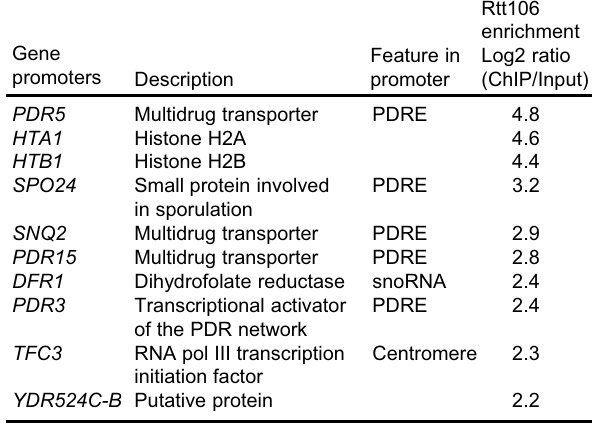
Fig. 1 Rtt106 binds promoters containing PDRE features. a Association of Rtt106 with the promoter of the histone gene pair HTA1-HTB1 , validating ChIP-seq analysis of Rtt106-6HA performed in this study. RTT106-6HA cells in log phase were collected for ChIP-seq analysis. Input, sequence reads of the sonicated genomic DNA before ChIP. Rtt106 ChIP, sequence reads of ChIPed DNA with Rtt106-6HA. b ChIP-seq analysis of Rtt106 showing association of Rtt106 with the promoter of the PDR5 gene. Positions of PDRE indicated by magenta lines. PDRE PDR responsive element. c The top 10 peaks of Rtt106 binding at promoter regions. Enrichment of Rtt106 at promoters was calculated as ChIP sequence reads normalised by Input sequence reads in a region spanning 500 bp upstream of the transcription start site of each HTA1 - HTB1 promoter was not affected by the loss of Pdr1 and Pdr3, as expected since the HTA1 - HTB1 promoter does not